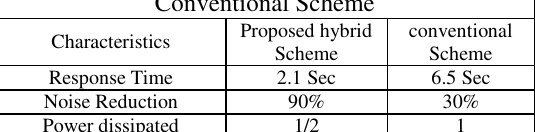
Table 3: Comparison of Proposed Hybrid and Conventional